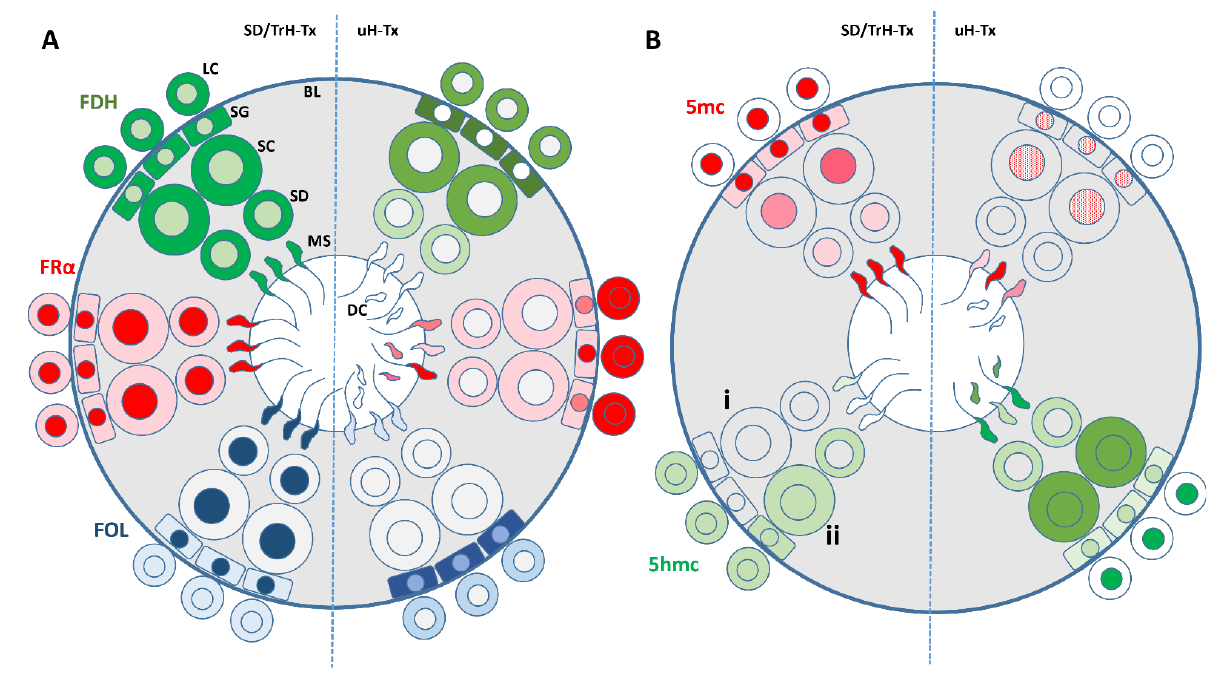
Figure 6. Summary diagrams of the main findings from this study. ( A ) Diagram showing localisation and relative concentrations of FDH (green), FR α (red) and folate (FOL) (blue) in SD controls and treated H-Tx (SD/TrH-Tx— left hemisphere) compared with untreated H-Tx (uH-Tx— right hemisphere). All cells contain FDH in the cytoplasm and nucleus in SD and TrH-Tx. In uH-Tx all cells except mature sperm contain FDH in the cytoplasm, at higher levels in spermatogonia (SG) and Spermatocytes (SC) but less in Spermatids (SD). Mature sperm (MS) in uHT-x contain no FDH and many dead and fragmented sperm (DC) are found in the lumen of the tubules. FR α (red) is mainly localised in nuclei including sperm heads with lower levels in the cytoplasm of SD and TrH-Tx. In uH-Tx, FR α fills Leydig cells (LG) but is present at low levels in the cytoplasm of spermatocytes and spermatids with no expression in nuclei except in spermatogonia and some sperm heads including fragmented sperm. In SD and TrH-Tx, folate (FOL) (blue) is concentrated in nuclei with low expression in the cytoplasm of spermatogonia but not in the cytoplasm of other cells except Leydig cells that have low levels in cytoplasm and nuclei. In uH-Tx, folate is concentrated in the cytoplasm and nuclei of spermatogonia but in no other cells except very low levels in sperm heads and in the cytoplasm of Leydig cells. ( B ) Diagram showing the methylation status, measured as 5-methyl cytosine (5mc), and demethylation status, measured as 5-hydroxymethyl cytosine (5hmc), in SD controls and treated H-Tx (SD/TrH-Tx— left hemisphere) compared with untreated H-Tx (uH-Tx— right hemisphere) associated with the findings in ( A ). All cell nuclei are methylated in SD and TrH-Tx with some staining in the spermatogonia cytoplasm, presumably associated with high levels of RNA. In uH-Tx low levels of methylation are found in spermatogonia and spermatocytes but none is seen in spermatids although there are some in some mature sperm and dead fragments. The marker of demethylation, 5-hydroxymethyl cytosine (5hmc) is not present in any cells except Leydig cells in SD controls (i) but in TrH-Tx (ii) all cells have low levels in cytoplasm and nuclei but not in the nuclei of spermatids or sperm heads. In uH-Tx, 5hmc is at high levels in the cytoplasm and nuclei of spermatocytes, lower levels in spermatogonia and only in the cytoplasm of spermatids and some high levels in sperm heads and fragments. Low levels of FDH, FR α and folate in the cells, particularly in the nuclei of uH-Tx, would result in failure of methylation. The increased demethylation may be a physiological consequence of low folate and FDH as well as DNMT1. The increased FDH, FR α and folate, found in Western and dot blots of total tissue lysates, in the testes indicates a good supply to the organs but a failure in delivery and transfer into cells suggesting a concentration due to lack of use.